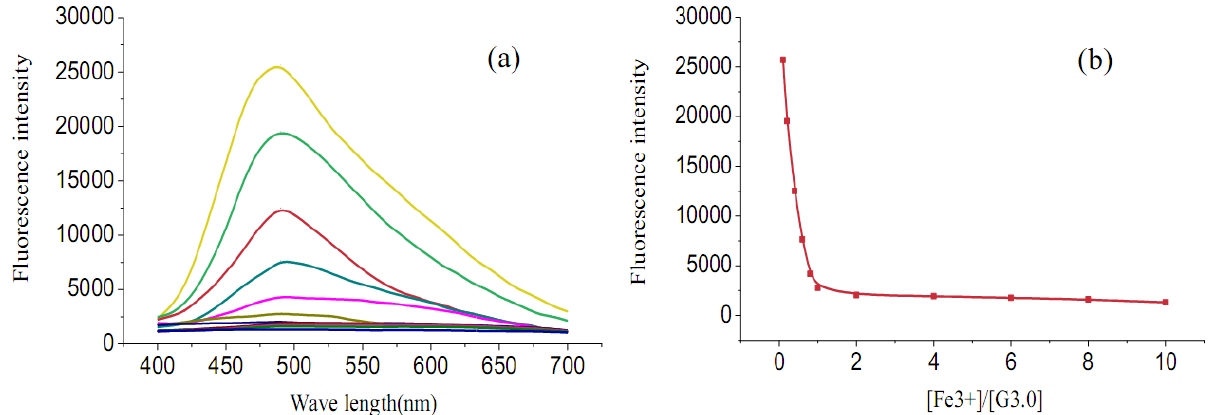
O/CH OH (1:1, v/v 2 3